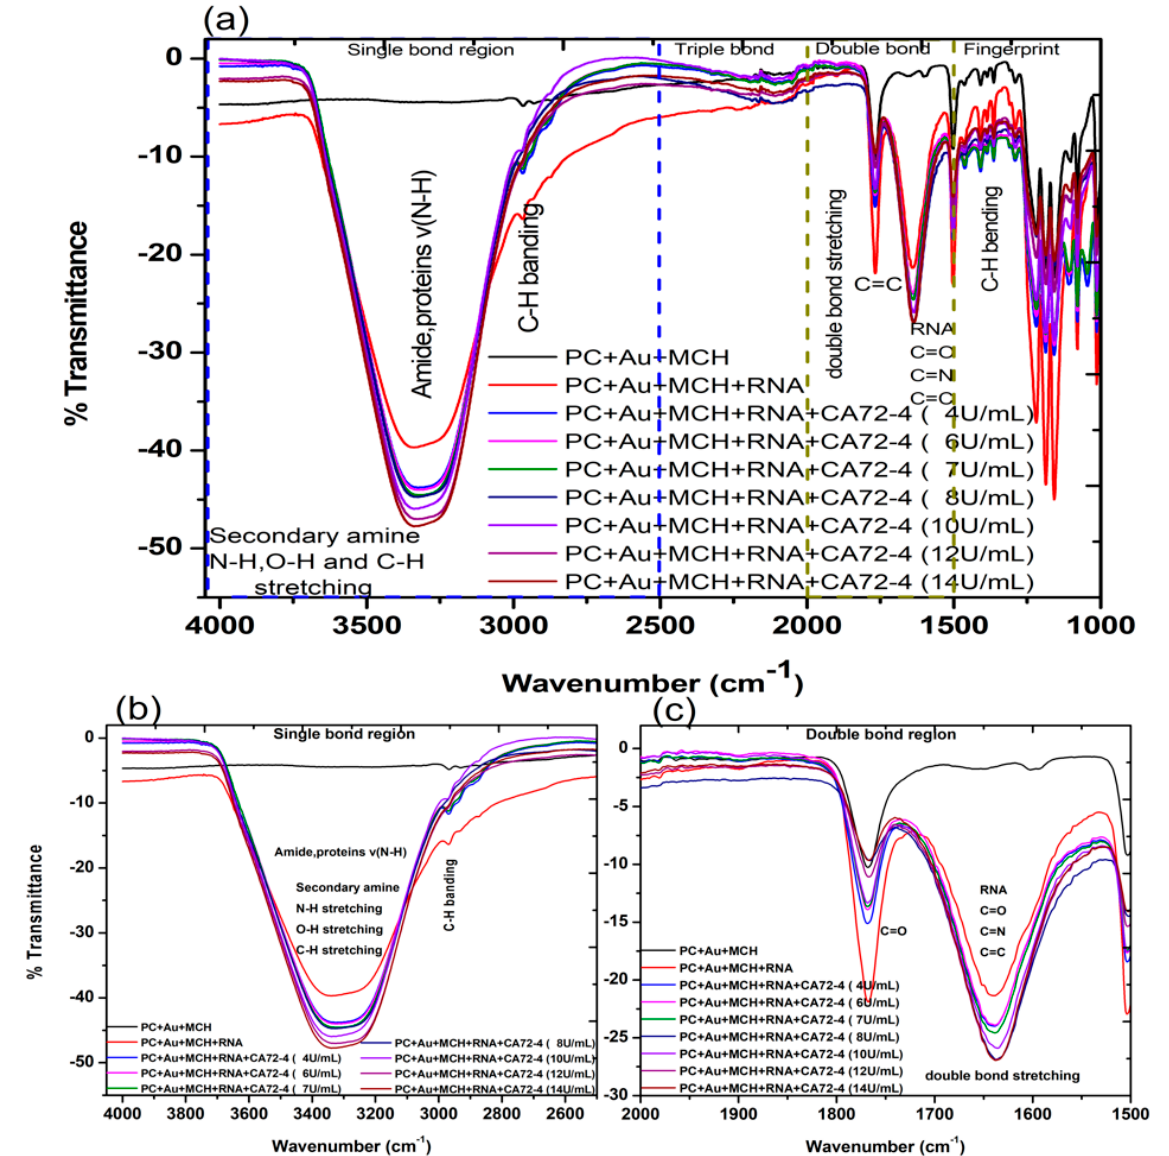
Figure 4. Fourier-transform infrared spectroscopy (FTIR) transmittance spectra of adsorption of different concentrations of cancer antigen CA 72-4 on our electrochemical sensor. ( a ) FTIR transmittance spectra for different concentrations ( b ) FTIR transmittance spectra for the single-bond region ( c ) FTIR transmittance spectra for the double-bond region.